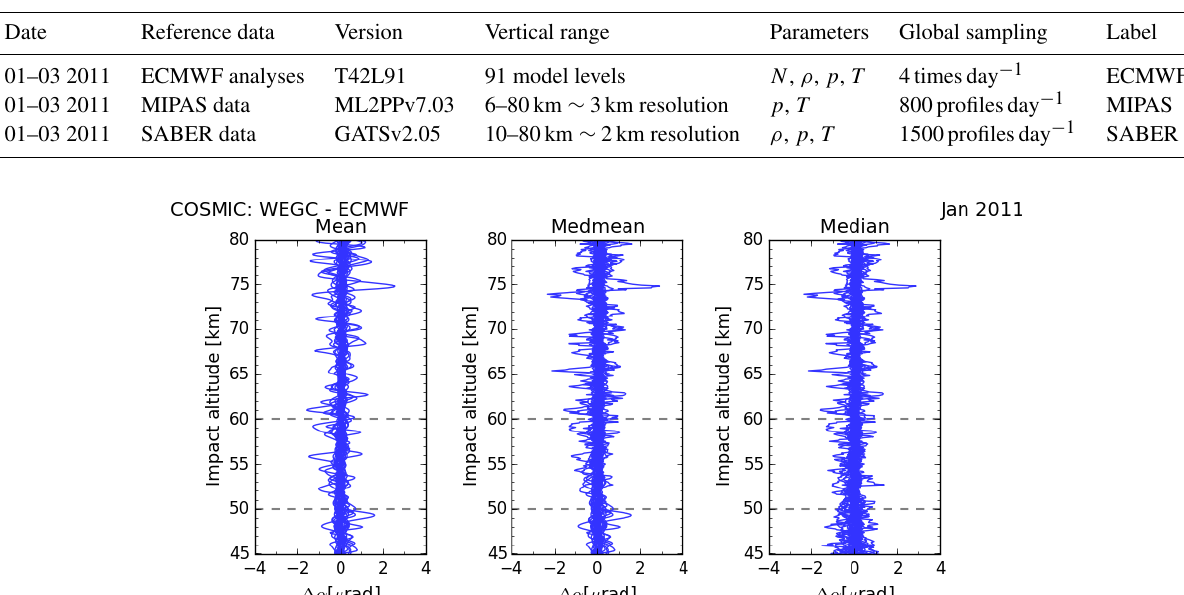
API and IPI processing. All refractivity differences are stud- ied as relative differences given as a percentage, while the temperature differences are given in Kelvin. Figure 3 shows the difference between API and IPI refractivity (left column) and dry-temperature (right column) climatologies, from Jan- uary to March 2011 (top to bottom). In analyses of the